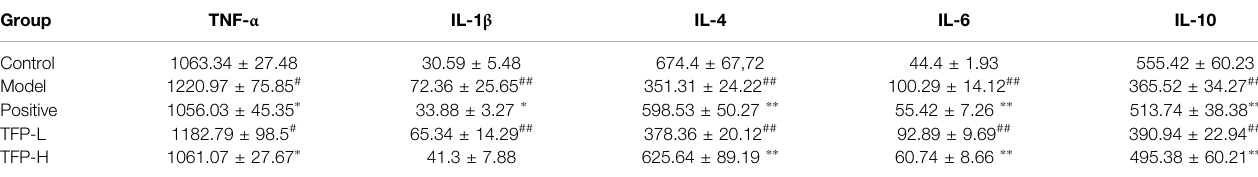
TABLE 1 | Changes of in fl ammatory factors after TFP therapy.